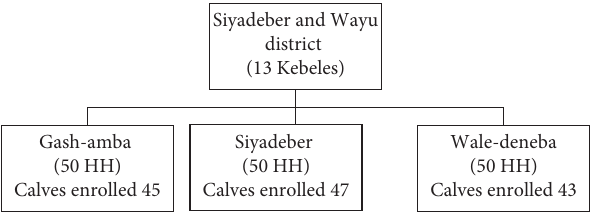
Figure 2: Schematic representation of sampling procedure for selecting study animal from Siyadeber and Wayu, North Shawa, Amhara regional state, Ethiopia,